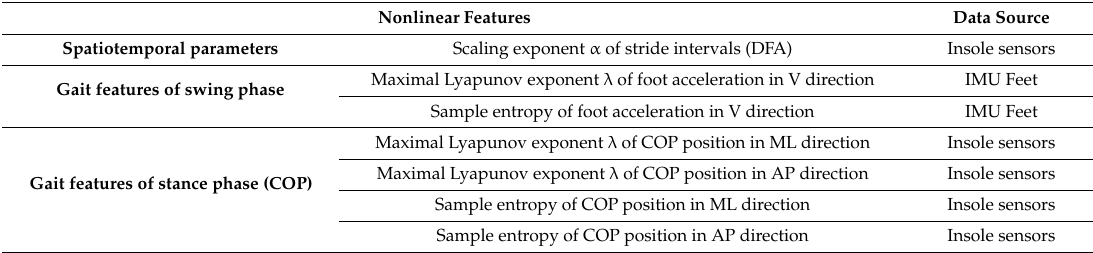
Table 3. Nonlinear features used in this study and the data source to calculate